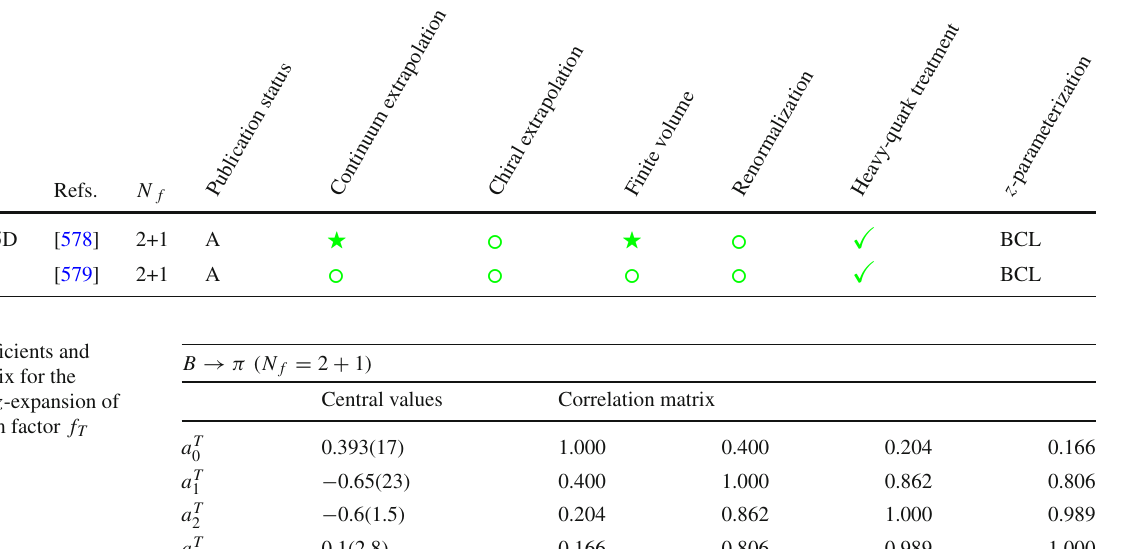
Table 49 Summary of lattice calculations of the B → K semileptonic form factors